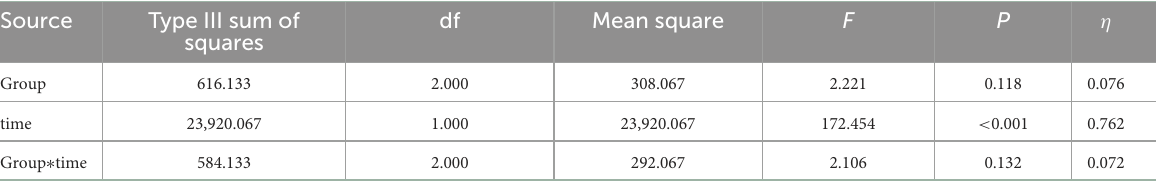
TABLE 5 Results of two-way ANOVA of DHI. Source